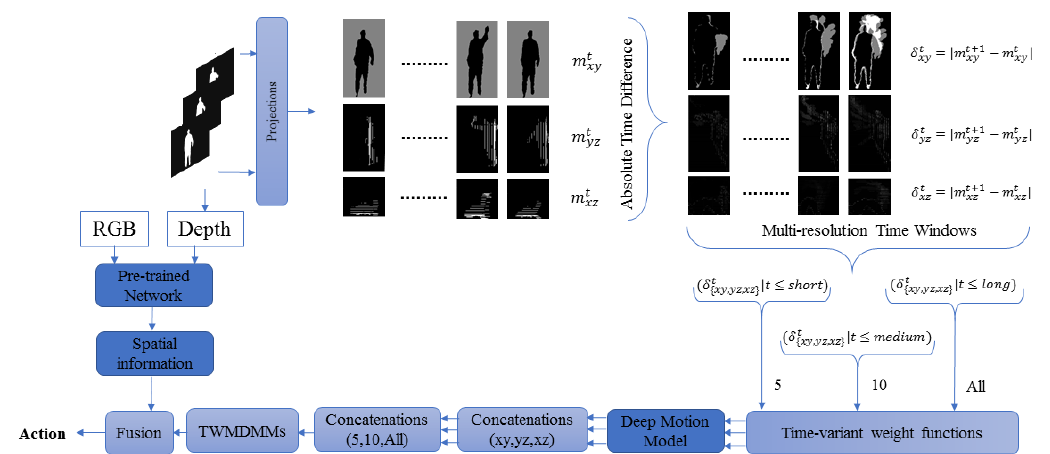
Figure 5. Recognition system stages using FWMDMM hand-crafted features and spatial information via deep motion model and pre-trained AlexNet